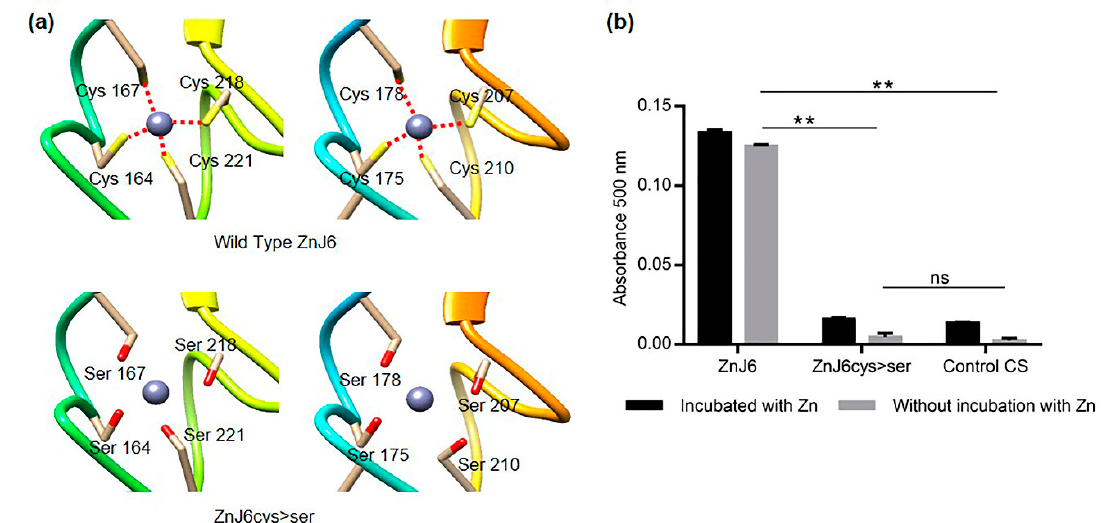
Figure 3. The cysteine-rich motif of ZnJ6 is required for its zinc-binding activity. ( a ) The structure of the Zinc-binding motif (Wild Type ZnJ6 and ZnJ6cys > Ser-mutant) was predicted using homology modeling (constructed by UCSF Chimera). The predicted loss of coordination (red dotted lines) with zinc due to the replacement of cysteine with serine in the ZnJ6cys > Ser-mutant; ( b ) Zinc-binding activity of ZnJ6 (WT and ZnJ6cys > Ser-mutant) was measured using 5 µM of purified recombinant proteins, either pre-incubated with 40 µM ZnCl 2 to completely saturate the protein with Zn, or without pre-incubation with Zn, representing the Zn-binding status of the protein extracted from bacteria. The release of zinc was obtained using para-chloromercuribenzoic acid (PCMB), and the PAR–Zn +2 complex that was formed was monitored at 500 nm. Citrate synthase (CS) was used as a negative control. The Zn-binding assays were performed in triplicates. One-way ANOVA with Tukey’s multiple comparison test was used to evaluate the differences in Zn-binding; error bars show the standard deviations (**: p value ≤ 0.01, ns: not significant). A significant change was observed between the Zn-binding of the WT protein as compared to the ZnJ6cys > Ser-mutant or the CS control. There was no significant difference between samples with or without pre-incubation with ZnCl.